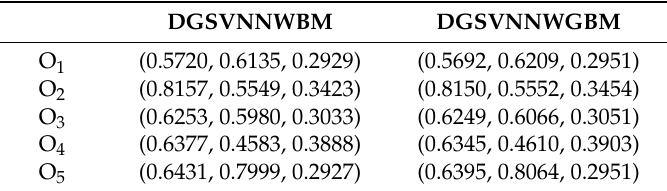
Table 1. The aggregating results of strategic suppliers by the DGSVNNWBM and DGSVNNWGBM ( R = ( 1,1,1,1 )